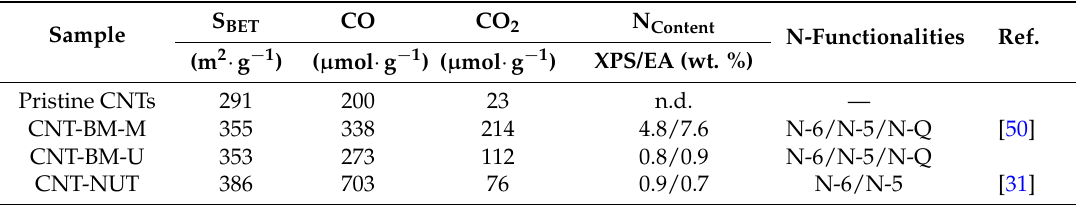
Table 2. Textural and chemical properties of N-doped CNT samples using melamine and urea as N-precursor by ball milling approach or hydrothermal